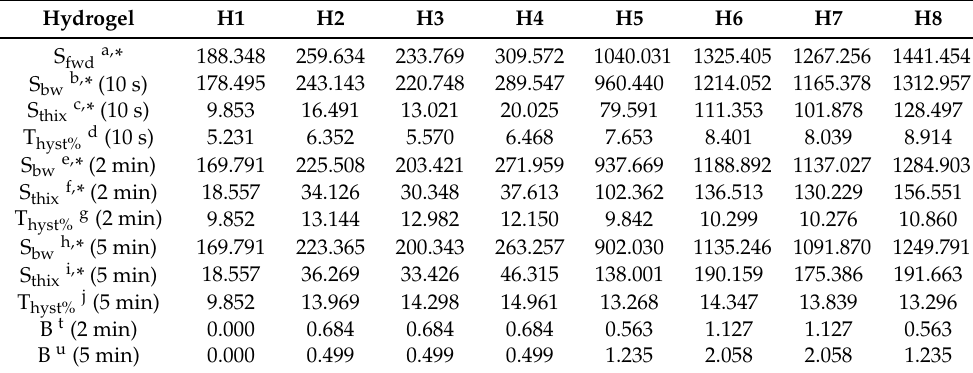
Symbol key: See footnotes of Table 5.